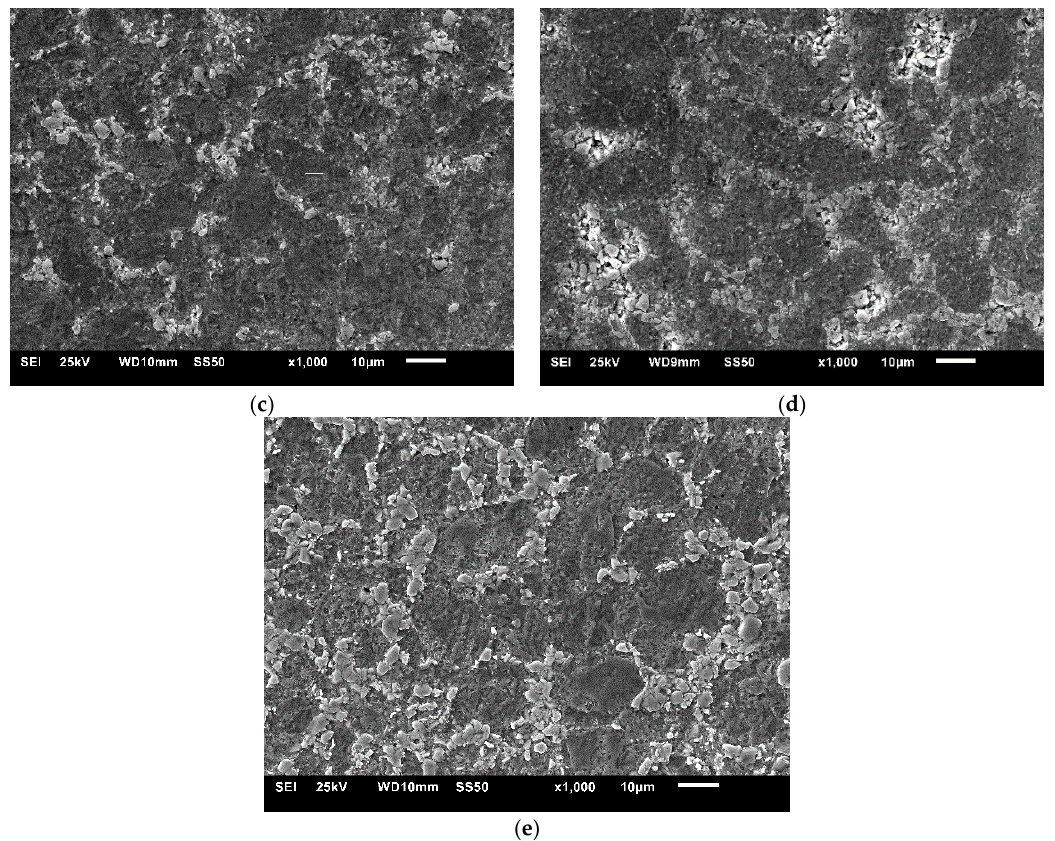
Figure 4. The microstructure (SEM) of ( a ) 316L steel and composites containing ( b ) 5% ZrB 2 , ( c ) 10% ZrB 2 , ( d ) 15% ZrB 2 and ( e ) 20% ZrB 2 .